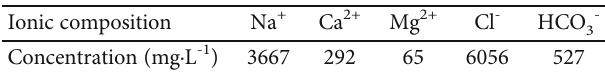
Table 1: The ionic composition and concentration of formation